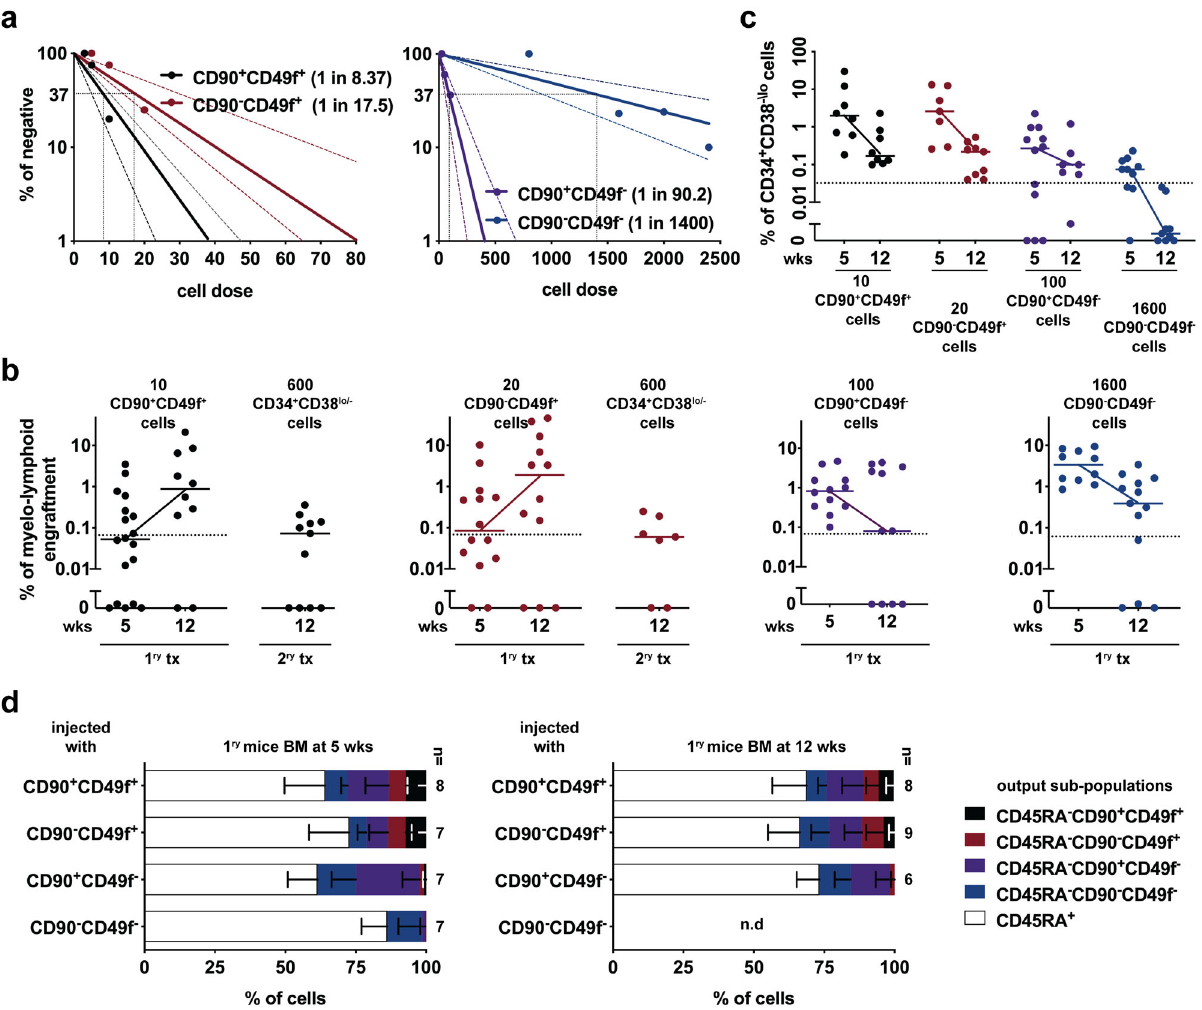
Fig. 1 Both CD90 + 49f + and CD90 − 49f + self-renewing populations are interconvertible and give rise to the whole CD34 + compartment. a SRC frequency within the four most primitive populations measured by limiting dilution assay (LDA) at 12 wks post intravenous (i.v) transplantation. 95% con fi dence interval is shown (see Supplementary Data 1 for details). To obtain unbiased frequencies, similar number of male and female mice were used (Supplementary Fig. 1e). b Cell dose equivalent of ~1 SRC of each population was i.v injected into separate primary NSG recipients (1 ry tx) and human graft was determined at 5 and 12 weeks (wks) later ( n = 7 – 18 mice). Secondary transplantation (2 ry tx) was performed with ~1 secondary SRC dose of CD34 + CD38 lo/ − HSPCs (600 CD45 + CD34 + CD38 lo/ − cells) derived from CD90 + CD49f + and CD90 − CD49f + populations. Mice with suf fi cient human graft (above the dotted line, see “ Methods ” ) were used for analysis in ( c ). Each dot represents a mouse ( n = 7 – 12 mice); median lines are shown; results were from fi ve independent experiments. c Frequency of CD34 + CD38 lo/ − HSPCs within human graft found in the BM of 1 ry recipients. Mice with suf fi cient human graft (above the dotted line) were used for analysis in ( d ); median lines are shown ( n = 7 – 12 mice). d Frequency of the denoted output sub- populations within CD34 + CD38 lo/ − HSPCs found in mice engrafted at 5 and 12 wks with the indicated cell populations ( n = 6 – 9 mice). Percentages were calculated based on the gates shown in Supplementary Fig. 1f. n.d not detected. Bars are the mean values and error bars are the S.D for the no. of mice analyzed. Source data are provided as a Source Data fi